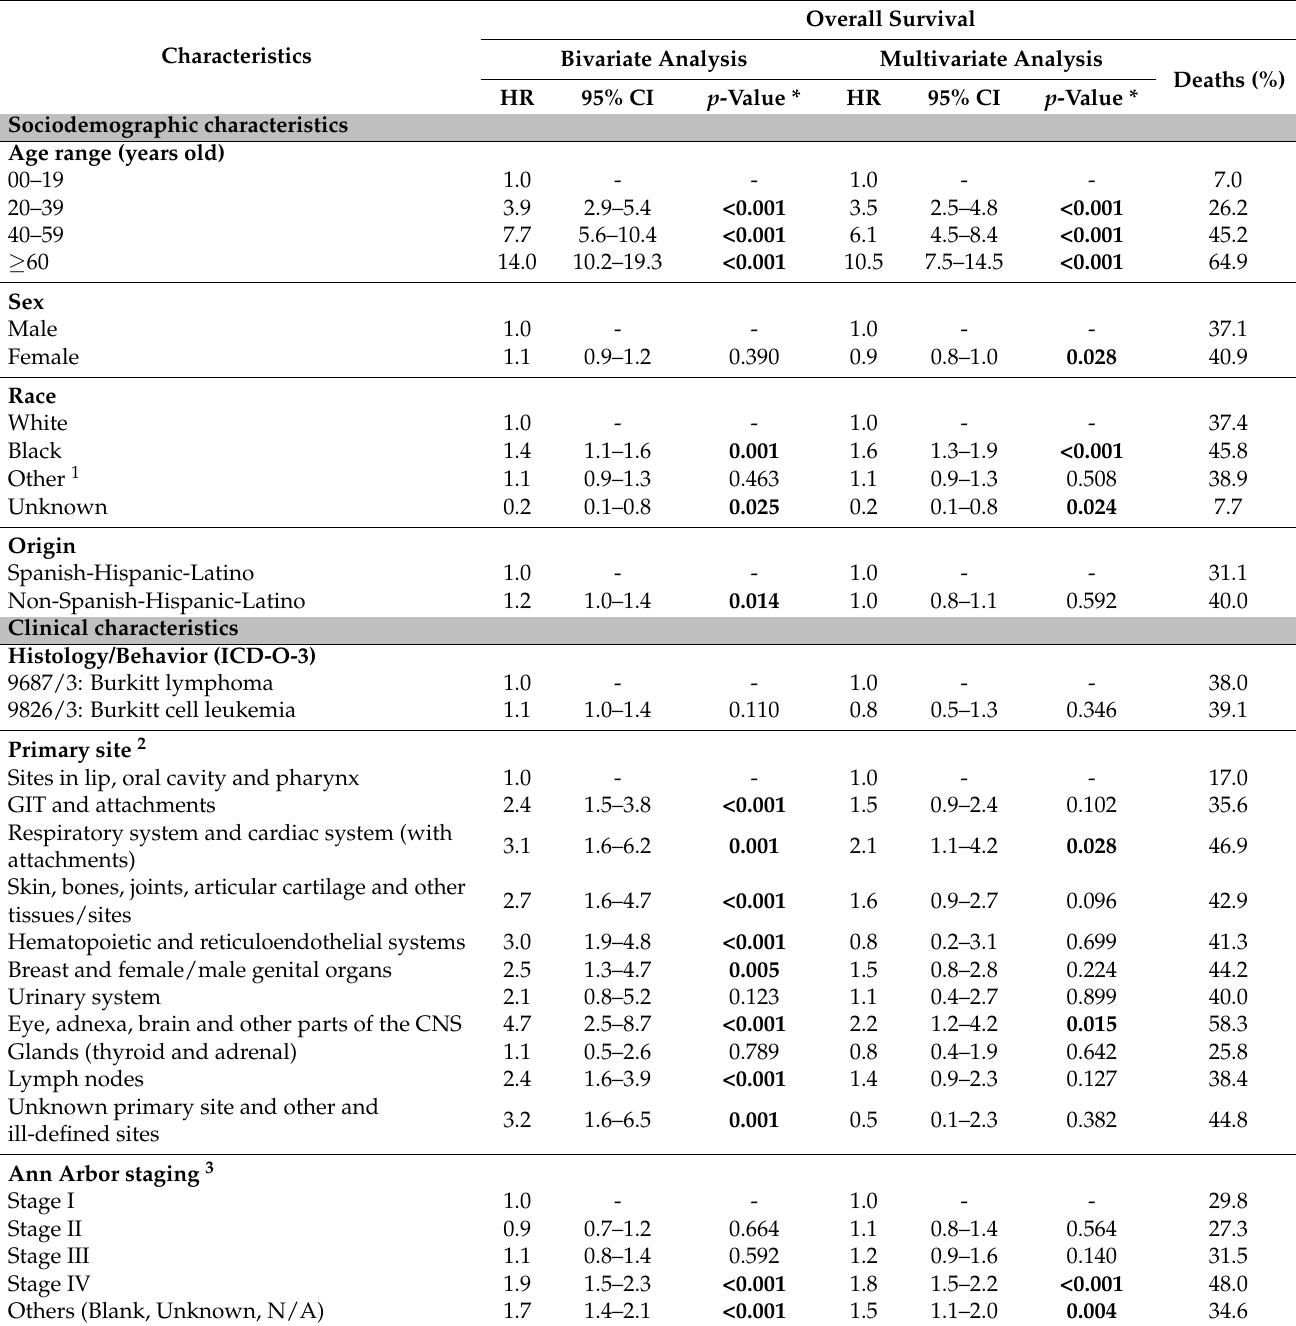
Table 2. Bivariate and multivariate analyses by a time-dependent covariate Cox regression model.